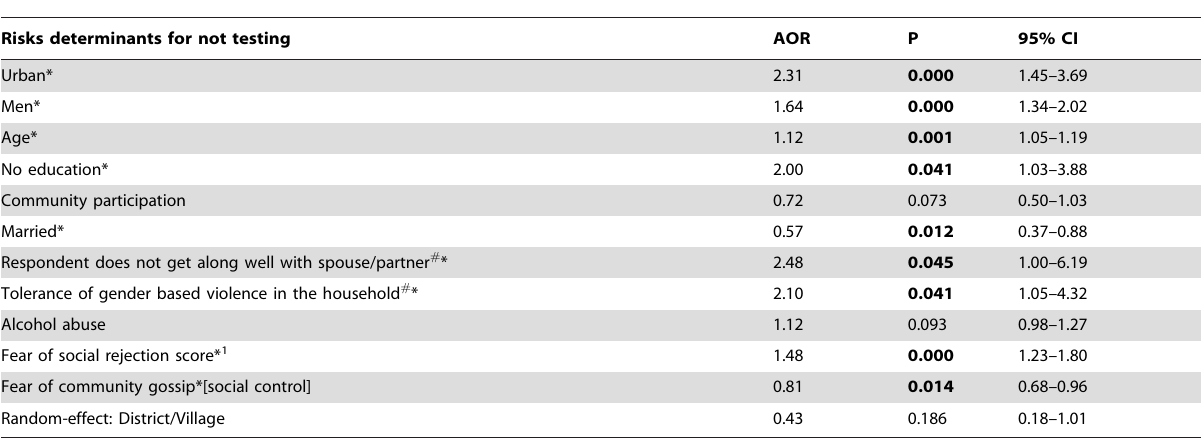
Table 7. Adjusted odds ratios associated with non-uptake of HIV